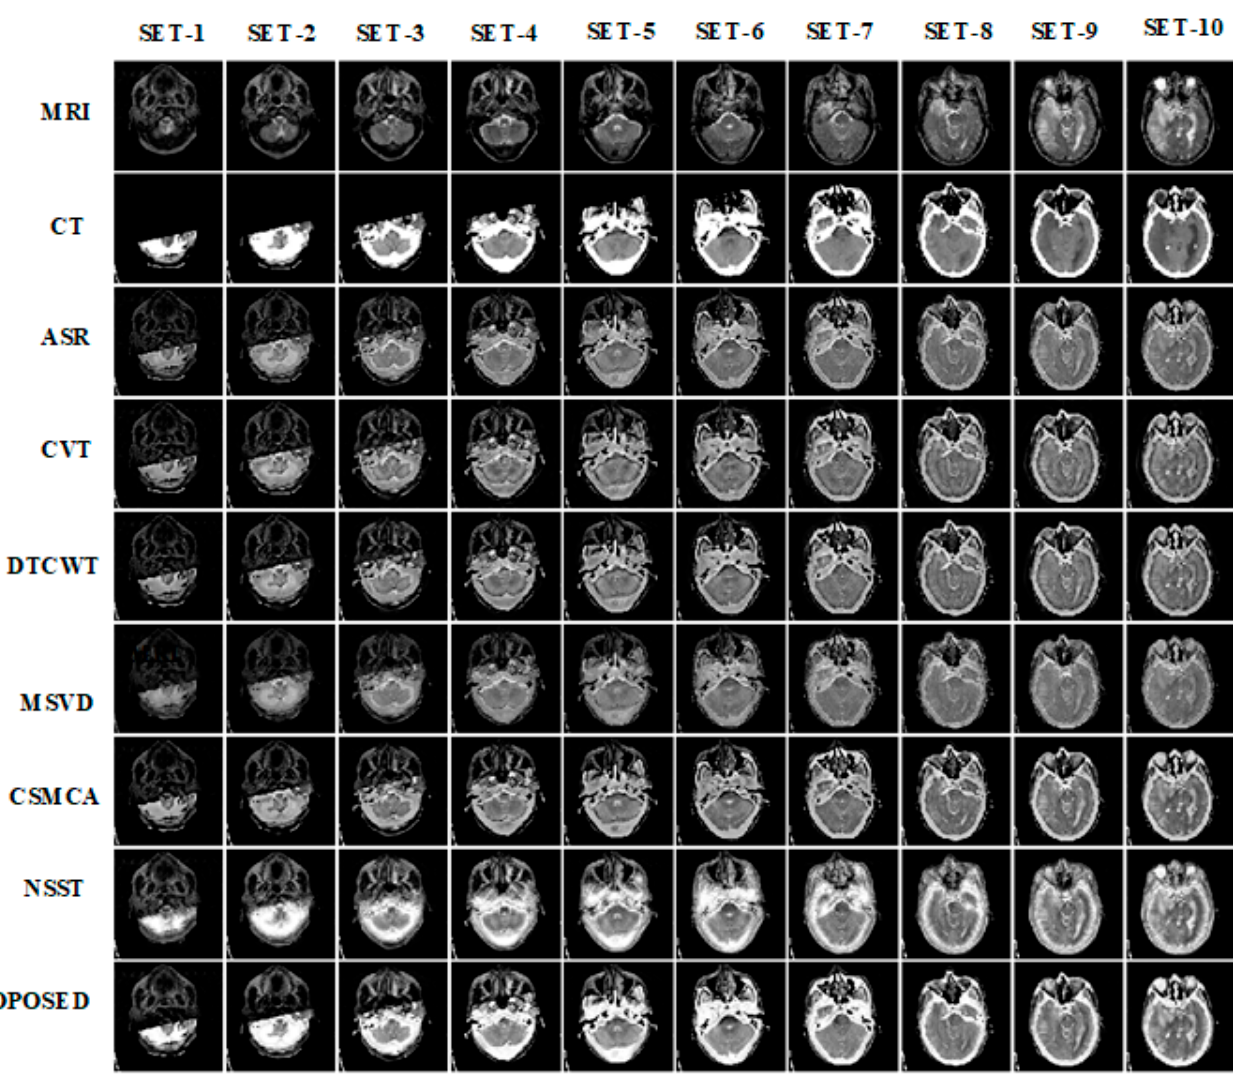
Figure 8. The results of various methods on first 10 pairs of MRI-T images (fatal stroke).